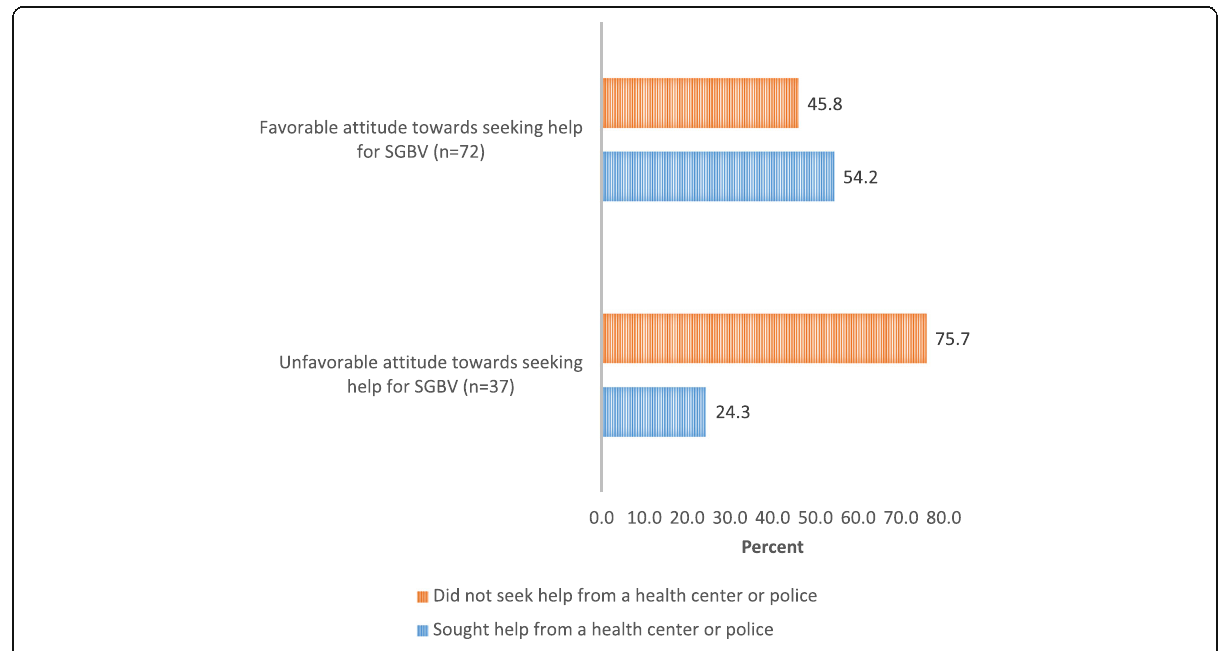
Fig. 2 Association between attitudes towards and actual help-seeking for SGBV